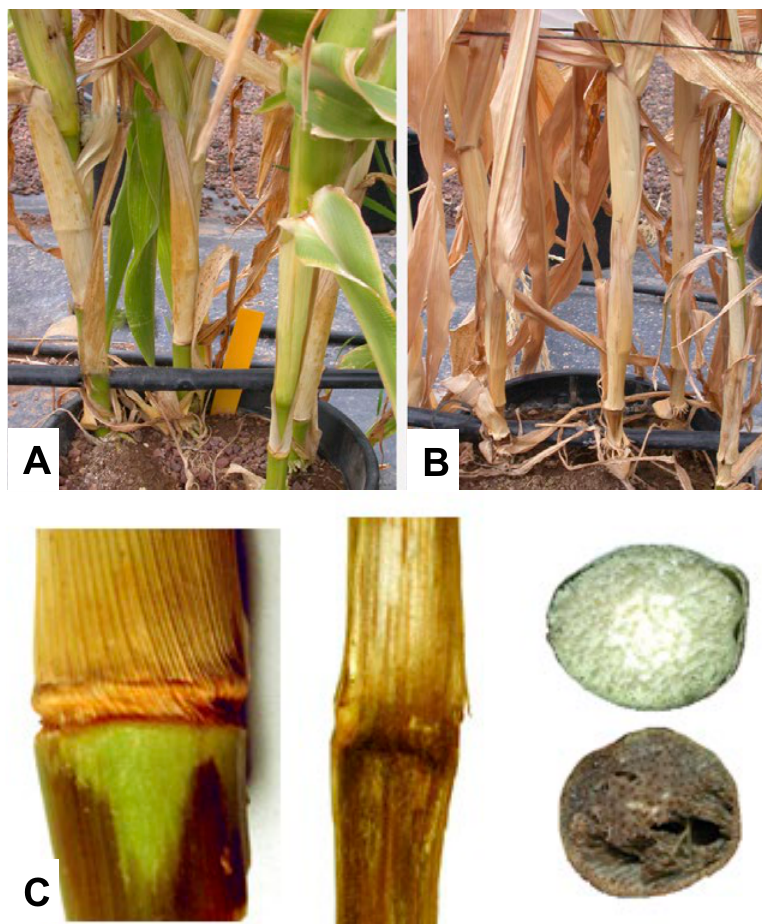
Figure 2. Testing Koch’s postulates for Harpophora maydis in a pathogenicity test. Severe disease symptoms appeared in maize plants grown in inoculated soil ( B ), while in non-inoculated soil ( A ) the plants developed normally, photographed 61 d after sowing; C , disease symptoms appearing on the stem as seen from the side (diseased plant on the right) and in cross section (diseased plant in lower